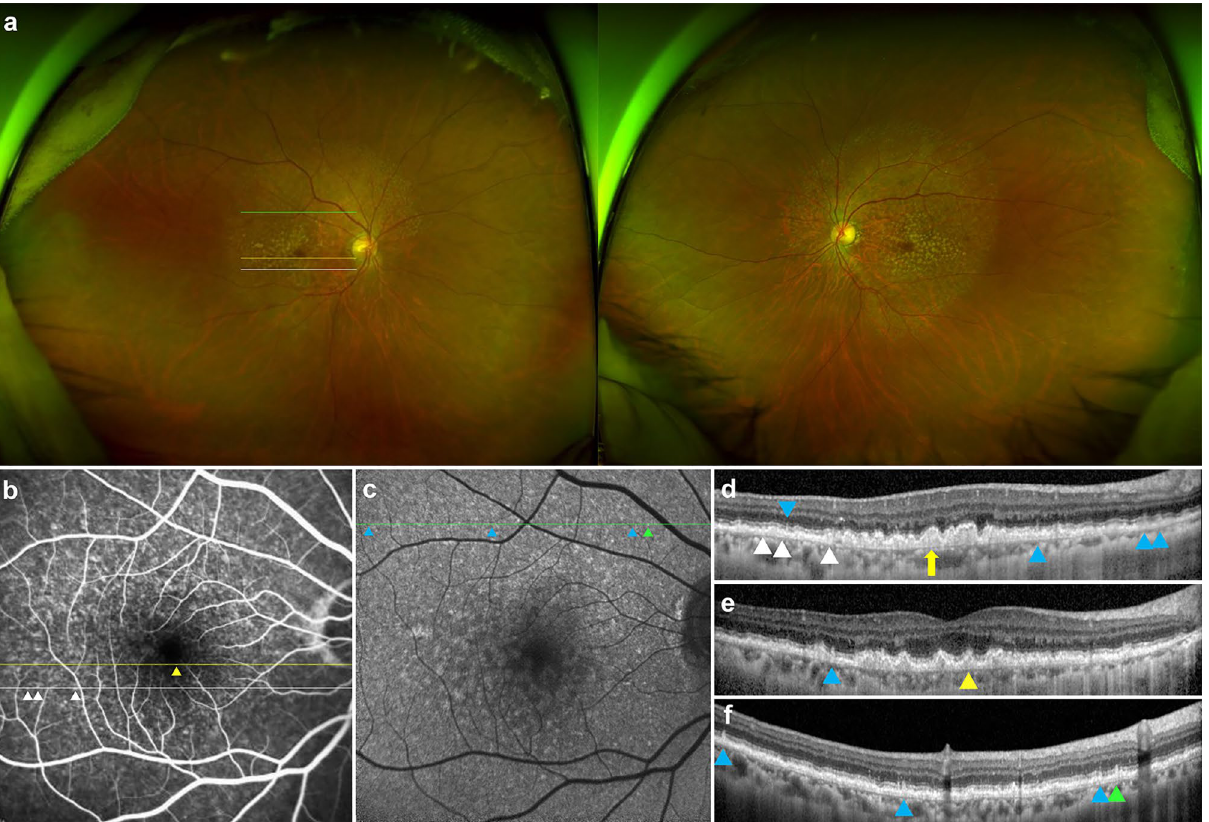
Figure 3. Multimodal imagings of a 62-year-old woman (Case 3). ( a ) Numerous yellowish and whitish deposits of various sizes are present in ultrawide-field photograph, and whitish deposits (reticular pseudodrusen) exist beyond the major arcades in both eyes. ( b ) Fluorescein angiography of the venous phase shows multiple hyperfluorescence of “stars-in-the-sky” appearance within the major vascular arcades. ( c ) Fundus autofluorescence shows numerous hypoaurofluorescent and hyperautofluorescent spots. ( d ) Optical coherence tomography (OCT) scan (white line in A and B) shows saw-tooth elevation of retinal pigment epithelium (RPE) corresponding to cuticular drusen (white arrowhead). Multiple subretinal deposits, corresponding to reticular pseudodrusen (blue arrowhead) and large drusen (yellow arrow, > 200 μm) are also observed. ( e ) OCT scan taken at the position of the yellow line in A and B shows sub-RPE deposit (yellow arrowhead) showing no fluorescence on Image B (soft drusen). A blue arrowhead indicates a reticular pseudodrusen. ( f ) OCT scan, obtained at the location of the green line in A and C, shows subretinal deposits corresponding to reticular pseudodrusen (blue arrowhead) and variant subretinal drusenoid deposits (green and younger than patients with RPD (72.6 ± 9.0 years) 15,16 . This cohort showed a female preponderance (85.7%), similar to Korean patients with CD (82.7%) or with RPD (86.2%) 15,16 . Although eyes with CD and RPD showed imaging features similar to those of CD or RPD, several features are worth mentioning. First, the mean SFCT of eyes with both CD and RPD was thinner than the previously reported mean SFCT of eyes with CD and eyes with RPD. It was reported that the mean SFCT was 220.1 – 317.5 µm in eyes with CD, and 174.6 – 186.2 µm in eyes with RPD 2,10,15,17–20 . In the present study, the mean SFCT of eyes with both CD and RPD was 143.8 ± 25.1 µm, which was the thinnest among the three groups. Moreover, it was reported that RPD eyes with neovascular AMD had thinner SFCT (145 ± 48 µm) than RPD eyes with dry AMD